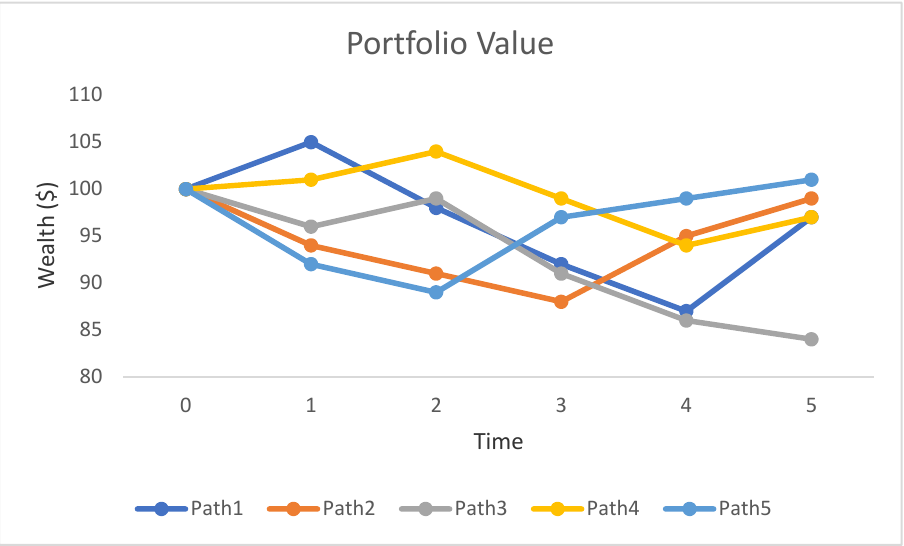
ff erence between VaR and Figure 2. Examining the difference between VaR and MaxVaR. Figure 2. Examining the di